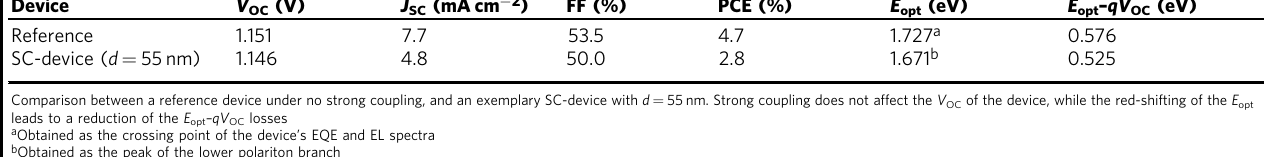
Fig. 1 Effects of strong coupling (SC) on the performance of SubNc/Cl 6 -PhOSubPc organic solar cells. a Device structure of a normal SubNc/Cl 6 -PhOSubPc solar cell employing ITO as bottom contact used as reference, and general device structure of solar cells exhibiting SC effects. For the SC-devices, the thickness d of the n-doped electron transport layer and p-doped hole transport layer are kept the same. b Normalized EQE spectra (upper panel) of the reference and an exemplary SC-device (with d = 55 nm) demonstrating the splitting of the absorption peaks of SubNc and Cl 6 -PhOSubPc (lower panel). The blue solid arrows indicate splitting of the absorption peaks of both materials into upper-polariton, middle-polariton, and lower-polariton (UP, MP, and LP, respectively). As a result, the EQE spectrum of the SC-device is redshifted and its low-energy edge steepened. Inset pictures show the molecular structures of SubNc and Cl 6 -PhOSubPc. c Current – voltage characteristic curves of the reference and SC-device show that the V OC remains rather constant under SC. d Excited-state diagram illustrating the splitting of the fi rst singlet excited state (S 1 ) into two polariton states. Electronic transitions (red arrows) can occur directly from the ground state (S 0 ) to the high-energy upper polariton (UP) and the low-energy lower polariton (LP). The energetically lower LP de fi nes the optical gap ( E opt ) of the polariton based solar cell Table 1 Effect of strong coupling (SC) on the photovoltaic parameters of SubNc/Cl 6 -PhOSubPc-based cells Device